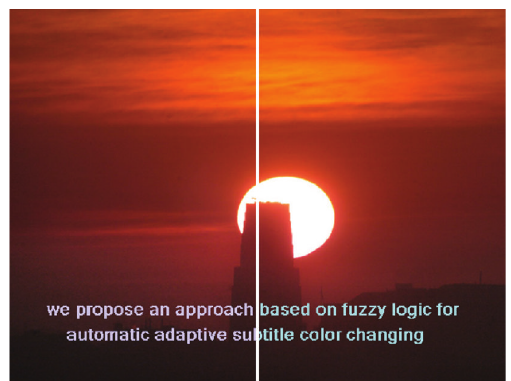
Figure 12: The image with the centroid values: R = 92, G = 38 and B = 28.